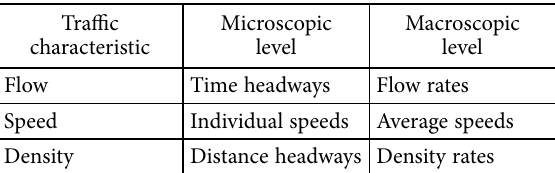
Table 1. Framework for fundamental characteristics of traffic flow (May 1990) Traffic